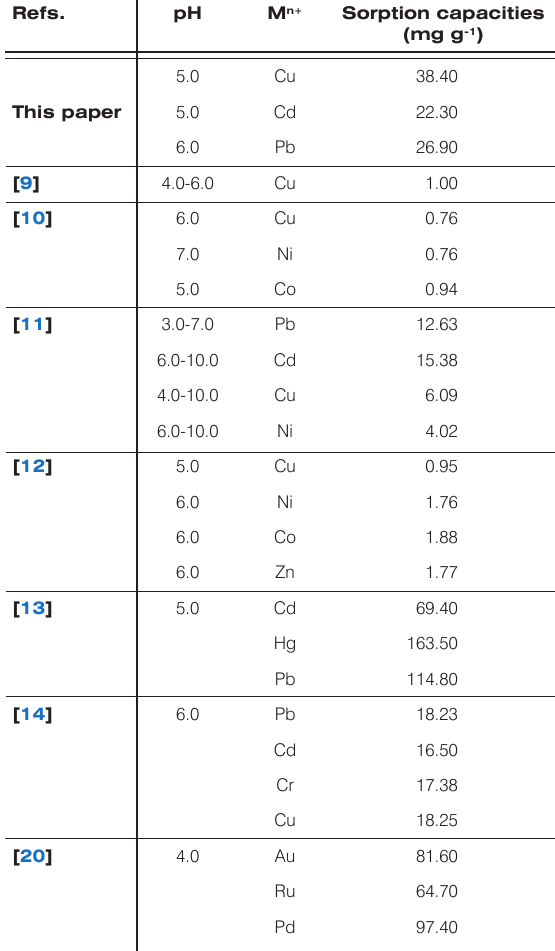
Table 3. Comparison of sorption capacities.